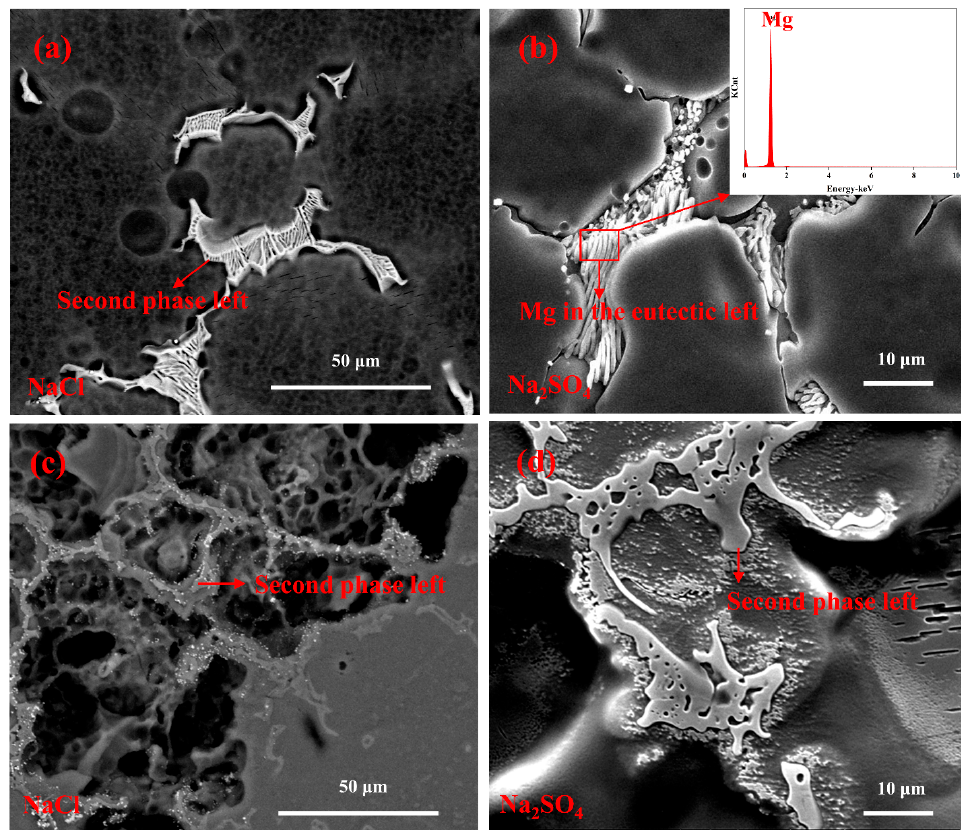
Figure 5. WE43 immersed in: ( a ) NaCl solution for 10 h, ( b ) Na 2 SO 4 solution for 10 h; AZ80 immersed in: ( c ) NaCl solution for 10 h, ( d ) Na 2 SO 4 solution for 10 h.